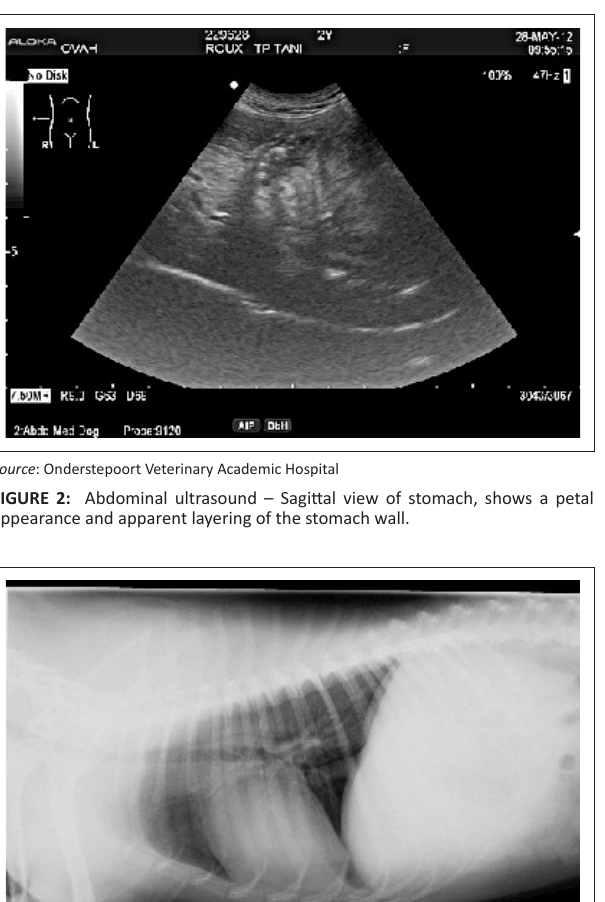
FIGURE 1: Abdominal ultrasound – Cardiac region of stomach shows a luminal, oval structure, 2.9 cm in length with a heterogenous appearance.